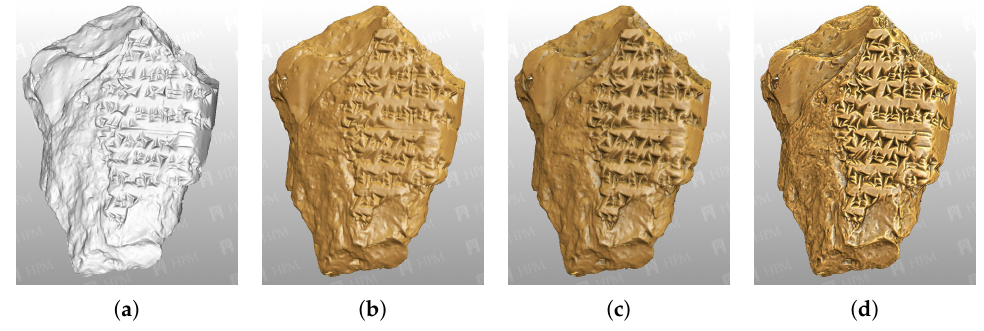
Figure 4. Rendering improvement over phong-shading ( a ) with lit-sphere shading ( b ), additional ambient occlusion ( c ) and additional ambient occlusion and radiance scaling ( d ) on cuneiform fragment E971.